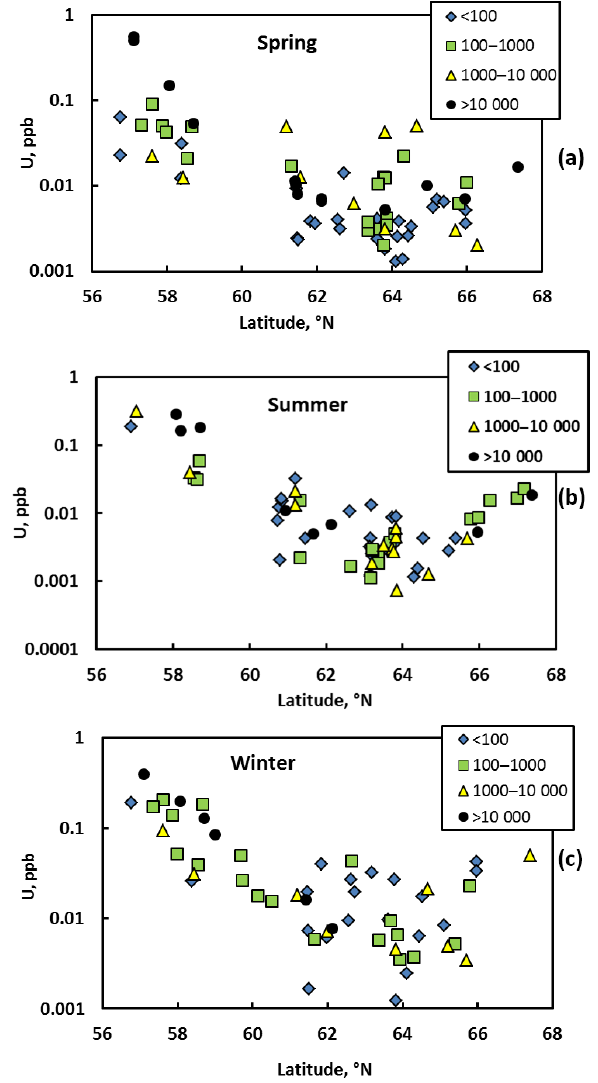
Figure 9. Variation in Mo concentration with latitude during spring (a) , summer (b) and winter (c) for watersheds of different size. The symbols are the same as in Fig. 2. A clear groundwater effect consists in a gradual decrease in concentration northwards, most visible during winter baseflow.